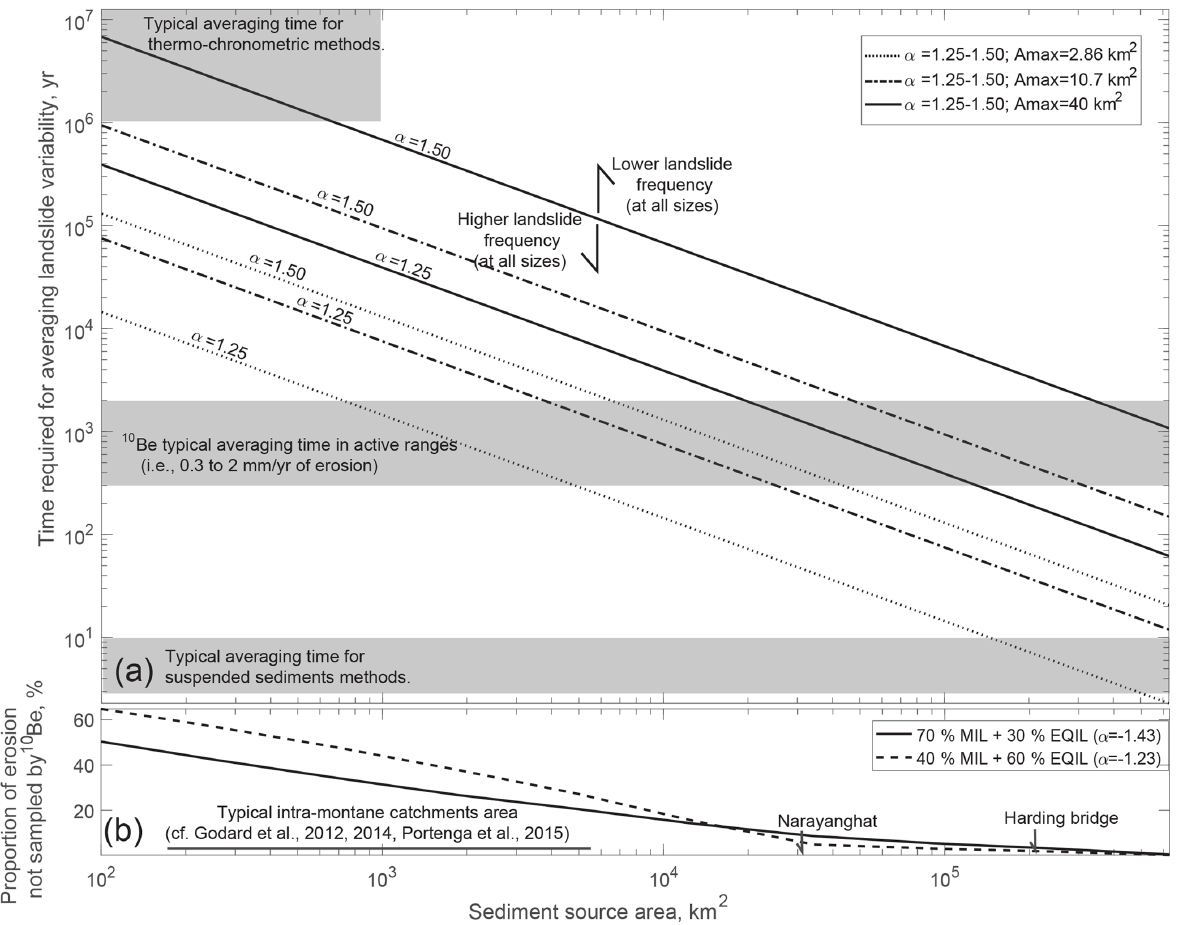
Figure 8. (a) Estimation of the time required for averaging the statistical variability in landslide erosion (taken as 3 / [ f max · A sed ] ), as a function of the size of the sediment source areas, A sed , and the properties of the landslide size–frequency distribution. Typical catchment areas in Himalayan studies, as well as downstream sampling sites at Narayanghat or Harding Bridge are indicated, together with the range of averaging time for 10 Be measurements, fluvial sediments and thermo-chronometric methods. Note that thermo-chronometric cooling ages are point measurements, but nearby samples are highly correlated up to 10–30km distance (Fox et al., 2016) as long as there are no breaks in the tectonic/erosional context (Schildgen et al., 2018). Hence, we believe this methods can be used for spatial scales of ∼ 100–1000km 2 , consistent with the catchment scales at which detrital thermo-chronometry seems to be valid (Ruhl and Hodges, 2005). The timescale is inversely proportional with the source areas but increases strongly with the maximal landslide scar area and the size–frequency power-law exponents ( α , or equivalently the return time of the largest landslides). An increase or reduction in the overall landslide frequency would result in a proportional change in the averaging timescale. (b) Proportion of erosion not sampled by 10 Be measurements averaging over 600 years against the sediment source area sampled. This estimate is based on the proportion of total erosion due to landslides larger than the one with a 600-year return in the Himalayas (Fig. 5), considering MIL and M w -corrected EQIL frequency with a decay similar to the Gorkha earthquake (solid line) or more heavy-tailed